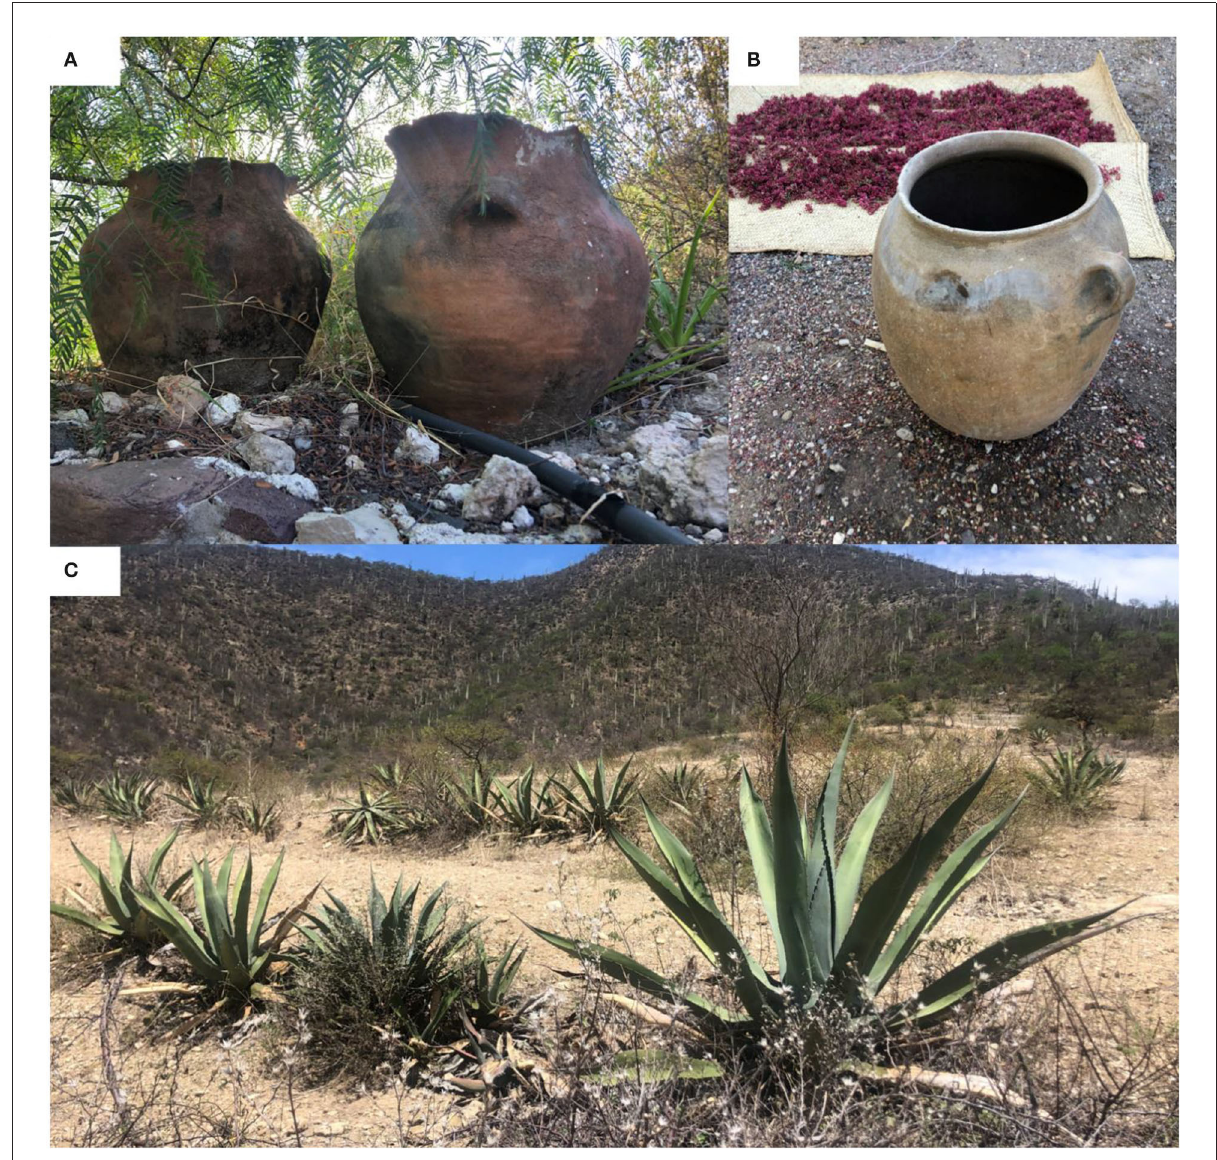
FIGURE5 Traditional vessels from the community of Los Reyes Metzontla for tolonche and pulque fermentation. (A) Old vessels for tolonche production, (B) modern vessels for tolonche production, also this clay containers are used for pulque production in small batches. (C) Agave salmiana plantations for pulque production in Los Reyes Metzontla